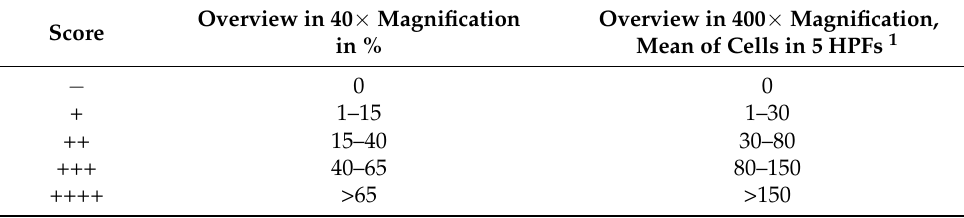
Table 1. Scoring system for immunohistochemistry and in situ